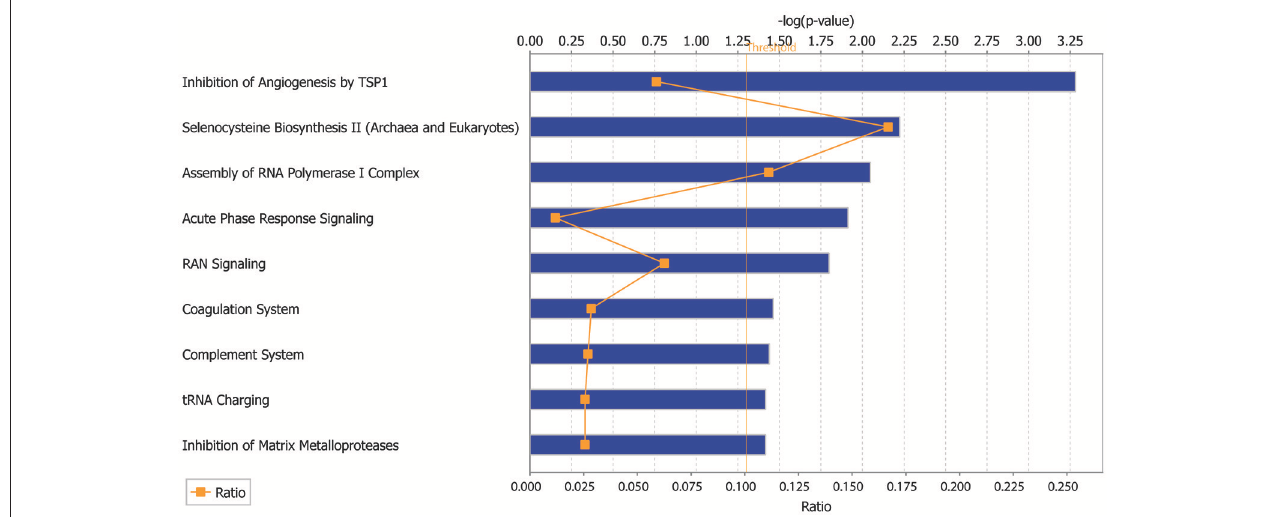
FIGURE 4 | Ingenuity Pathway Analysis (IPA) of the scRNAseq database showing the top canonical pathways enriched in the endothelial cells derived from SSc skin compared to those from healthy control skin.